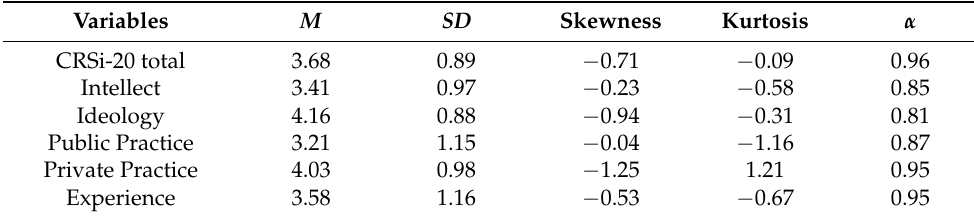
Table 2. Descriptive statistics for CRSi-20 and its subscales.